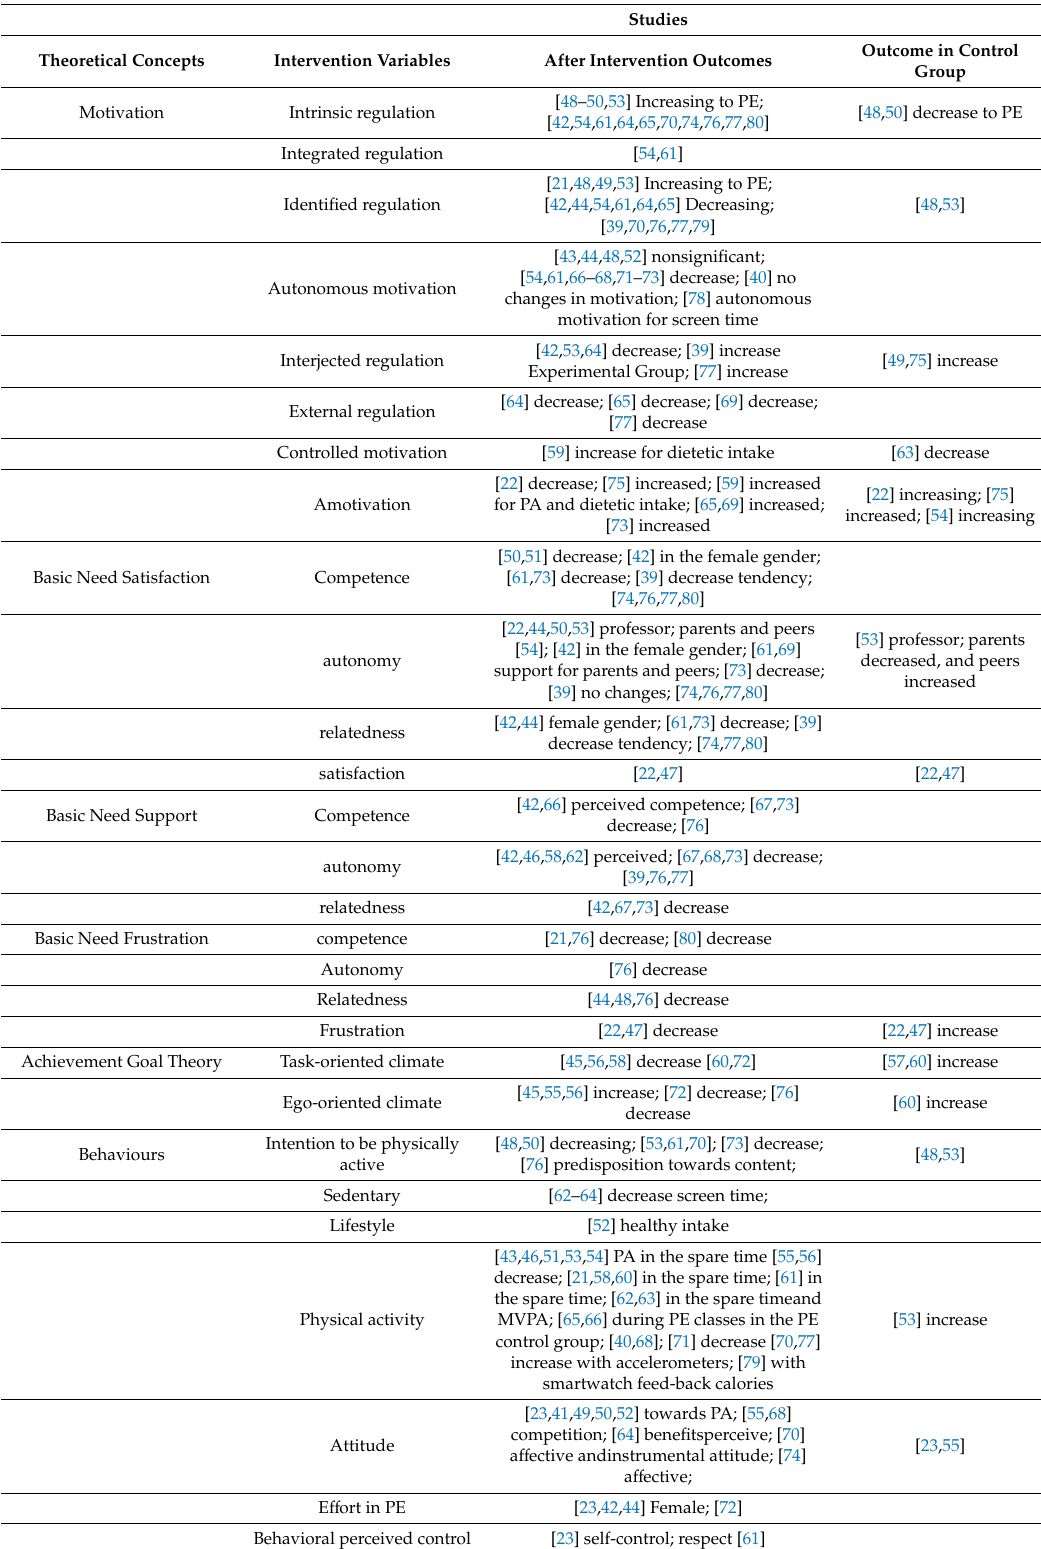
Table 4. Outcome syntax by